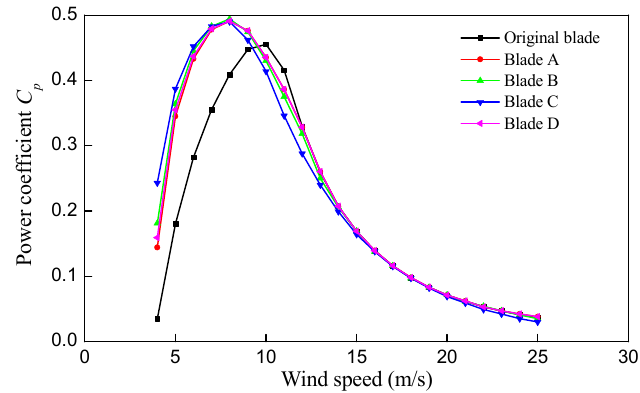
Figure 17. Comparison of power coefficients under different wind speed.